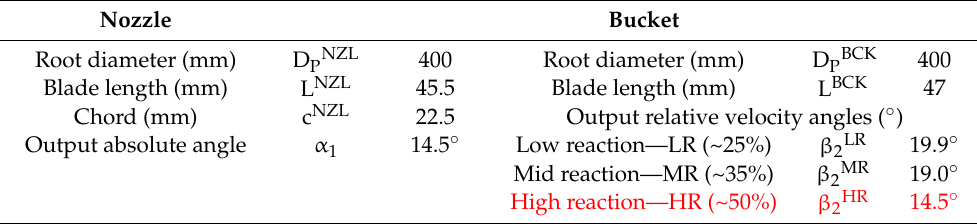
Table 1. Geometrical parameters of tested stages.